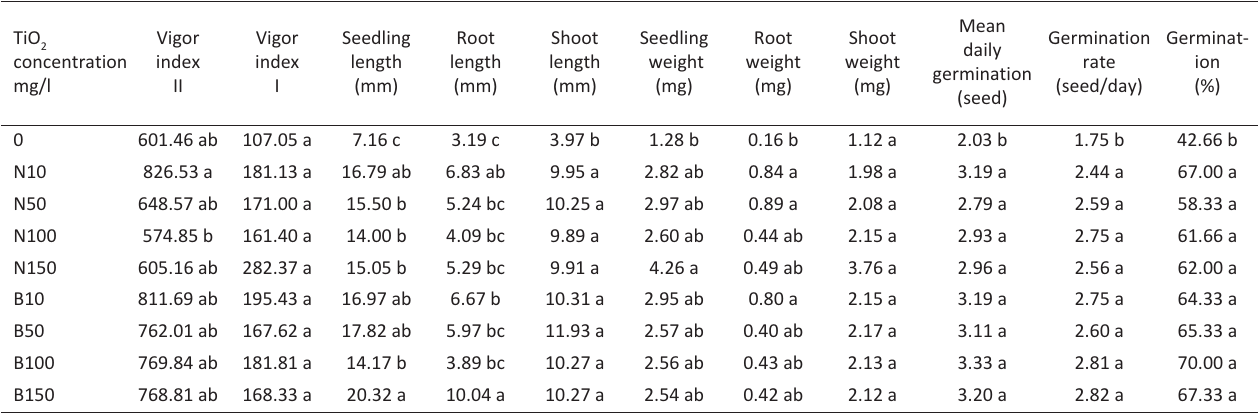
Means, in each column, followed by same letter are not significantly different at the 5% probability level, using Tukey Test.